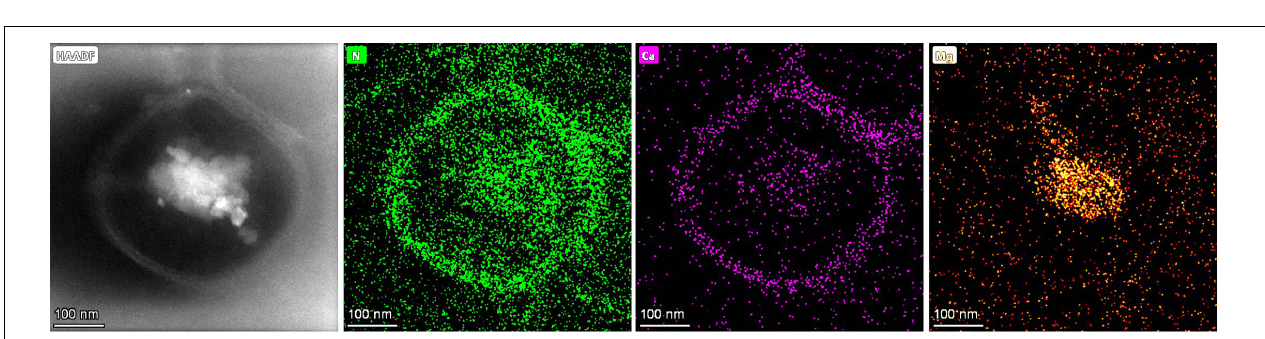
FIGURE 12 | Amino acids and polysaccharides in EPS extracted from Vibrio harveyi QPL cultured in a medium with various Mg/Ca molar ratios. (A) Amino acids in EPS of QPL2 cultured in a medium with no addition of Ca 2 + and Mg 2 + . (B) Acidic amino acids (Glu and Asp) in EPS with increasing Mg/Ca ratios. (C) The total amount of EPS with increasing Mg/Ca ratios. (D) The polysaccharide in EPS with increasing Mg/Ca ratios.